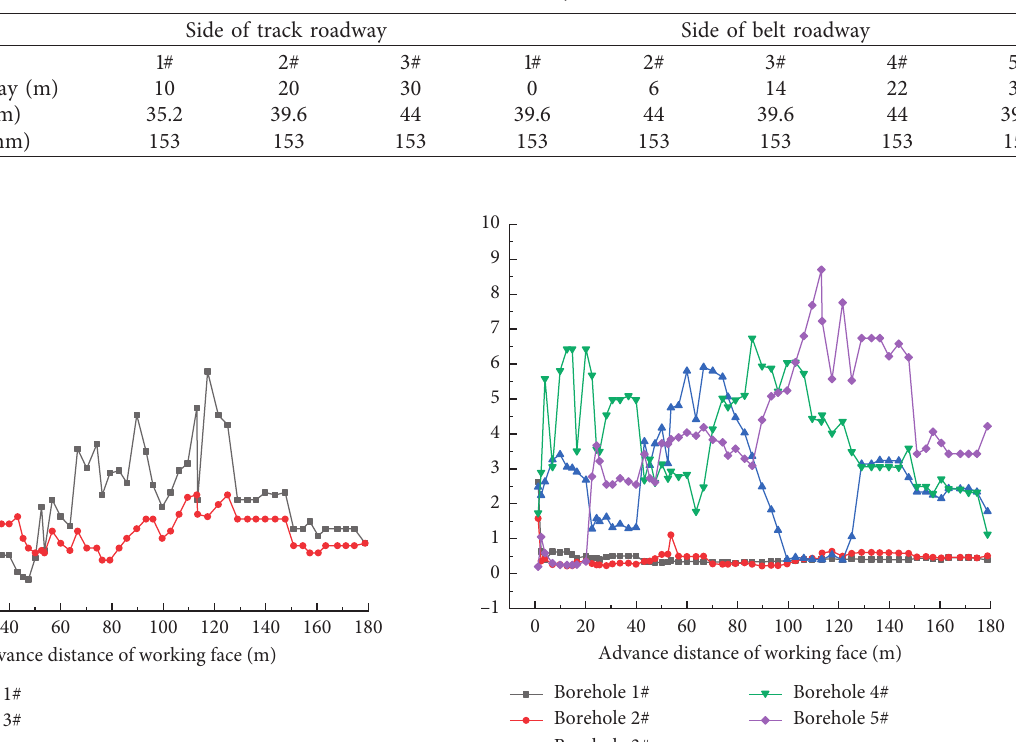
Table 3: Parameters for borehole layout.